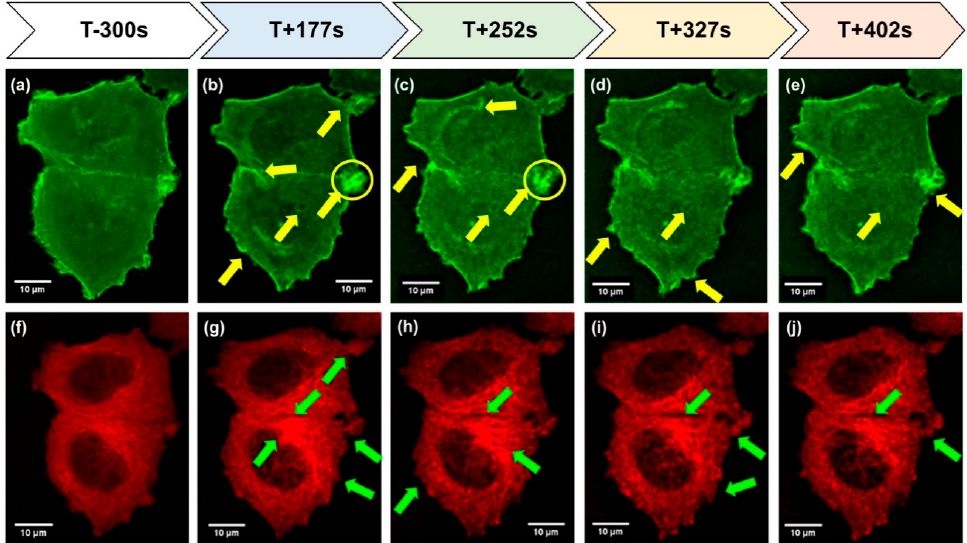
Figure 1. Time course and images of FLUMIAS on TEXUS 54 (40 × / 1.2). The MCF-7 breast cancer cells 5 min before launch (T-300 s) of the rocket and during the r- µ g phase (T + 177s–T + 402s). The yellow arrows show the changes in F-actin ( a – e ; green fluorescence). The yellow circles include an area with F-actin accumulations. Filopodia and lamellipodia are found after 150s, which are more pronounced with time. The green arrows indicate changes in α -tubulin ( f – j ; red fluorescence). The tubulin network reveals holes after 150s and a looser structure.